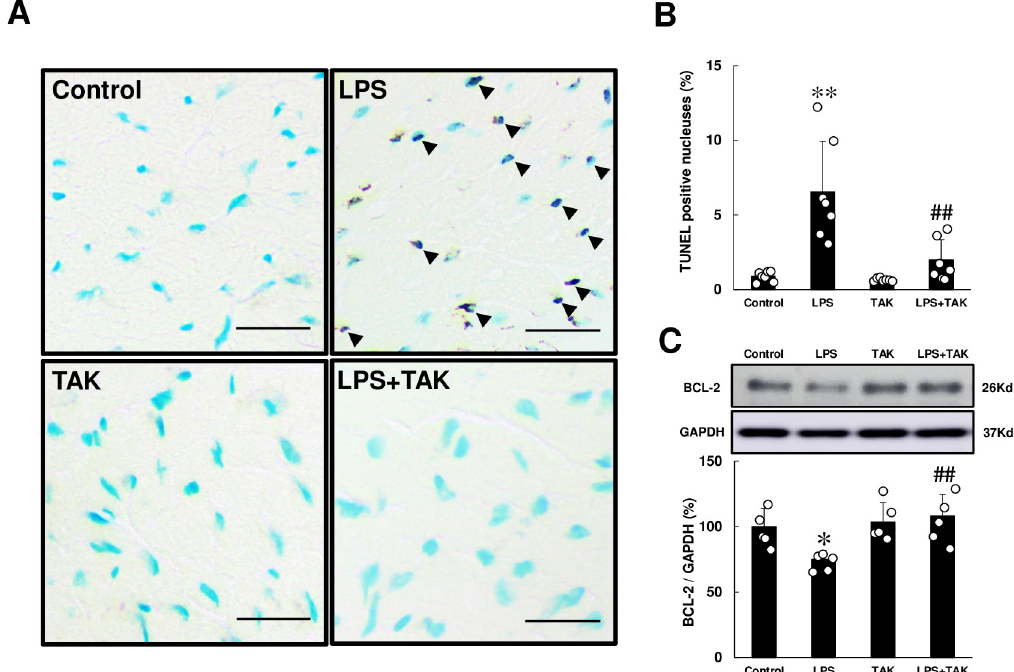
Fig 3. Effects of chronic PG-LPS infusion on cardiac myocyte apoptosis. (A) Representative images of TUNEL-stained sections of cardiac muscle in the Control ( upper left ), PG-LPS (LPS) ( upper right ), TAK-242 (TAK) ( lower left ) and PG-LPS + TAK-242 (LPS + TAK) ( lower right ) groups. Scale bars: 2 μ m. Black arrows: TUNEL-positive myocytes. (B) The number of TUNEL-positive myocyte was significantly increased in the PG-LPS group ( P < 0.01 vs. Control), and this increase was significantly attenuated by TAK-242. �� P < 0.01 vs. Control or ## P < 0.01 vs. PG-LPS group by one-way ANOVA followed by the Tukey-Kramer post hoc test. (C) Expression of anti-apoptotic BCL-2 protein was significantly decreased in cardiac muscle of PG-LPS-treated mice, and this change was significantly attenuated by TAK-242. � P < 0.05 vs. Control or ## P < 0.01 vs. PG-LPS group by one-way ANOVA followed by the Tukey-Kramer post hoc test. Full-size images of immunoblots are presented in S5 Fig of S1 Data . Data shows means ± SD and scattered dots show individual data.